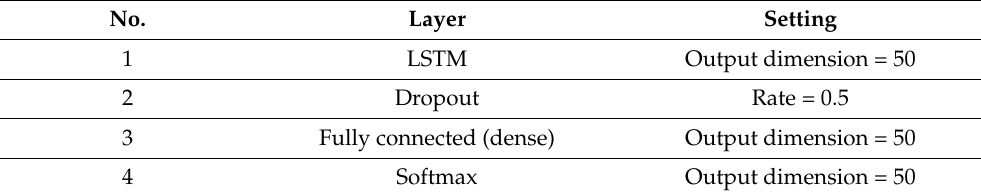
Table 8. Configuration of LC information recognition based artificial neural network.